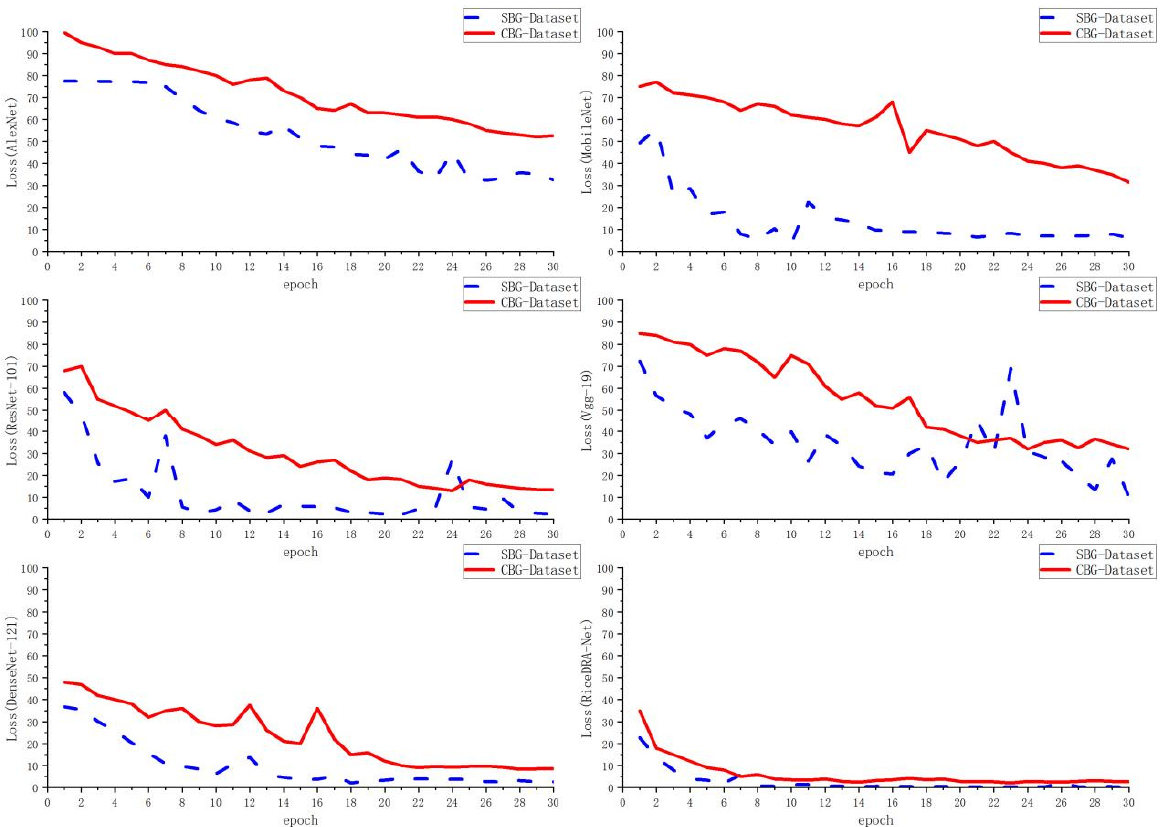
Figure 10. Comparison of the total loss values of the five different models on the test set in a single context.